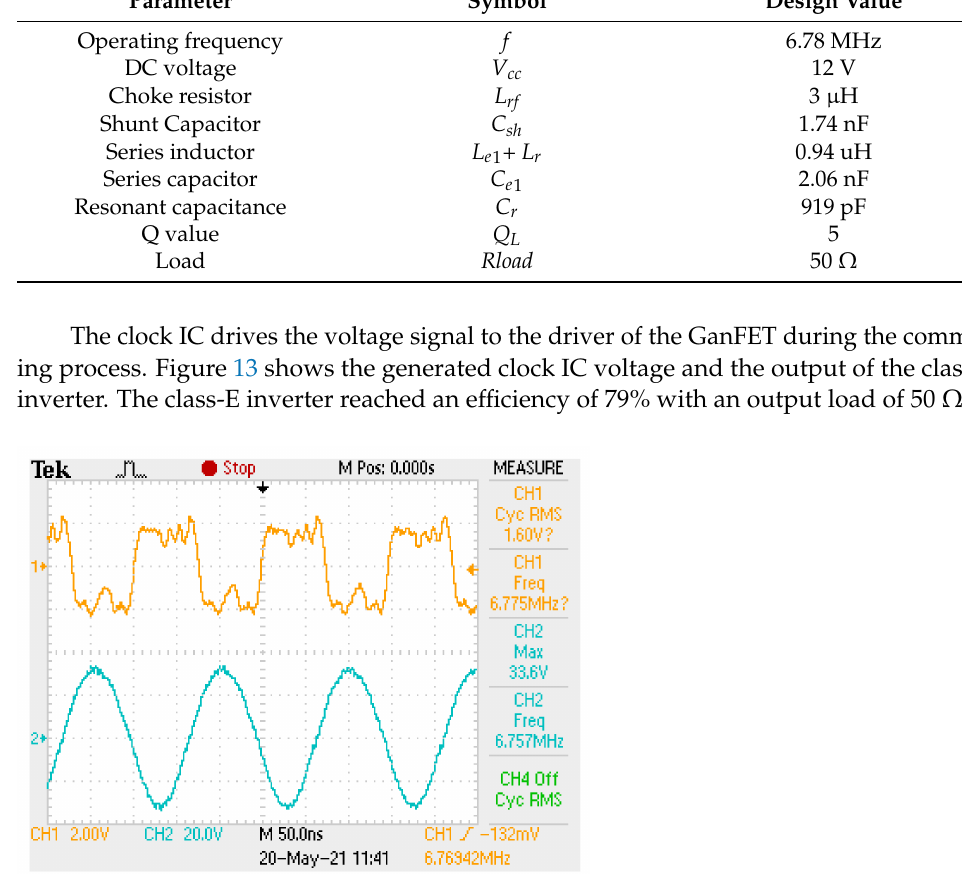
Figure 13. Clock voltage output and class-E voltage